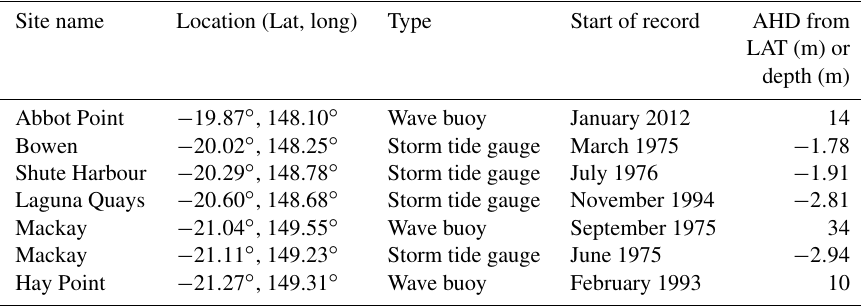
Table 1. Storm tide gauges and wave buoys used in this study (north to south). AHD conversion from local LAT is given if a site is a storm tide gauge, else mooring depth of water is given for wave